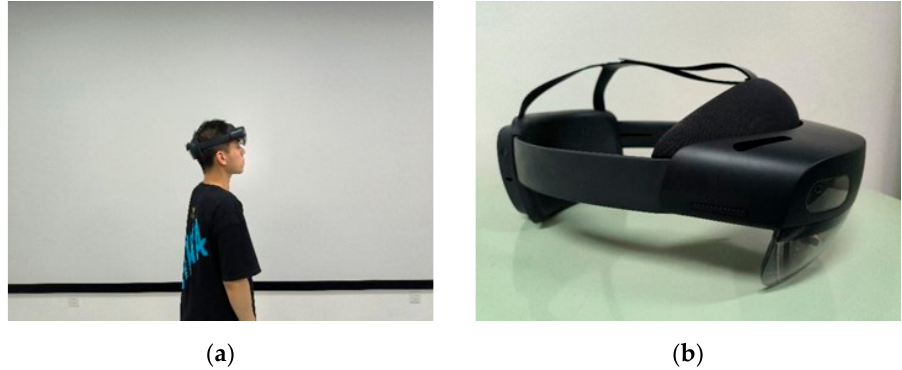
Figure 1. Experimental scenarios and equipment ( a ) the subject wearing the device; ( b ) Hololens 2 display device.